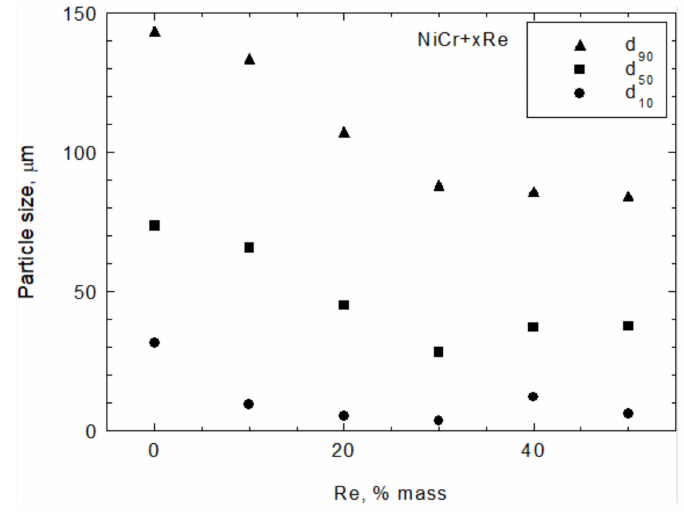
Figure 10. Average particle size for d 10 , d 50 , and d 90 fractions of Ni20Cr + xRe powders.